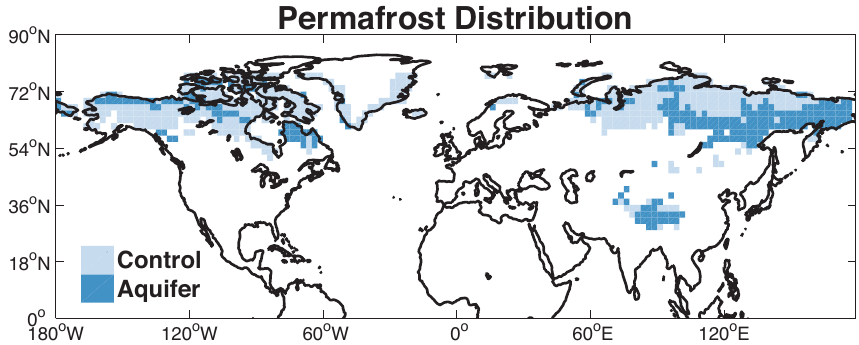
Fig. 4. Permafrost extent in the Control run (light blue) and additional permafrost area in the Aquifer run (dark